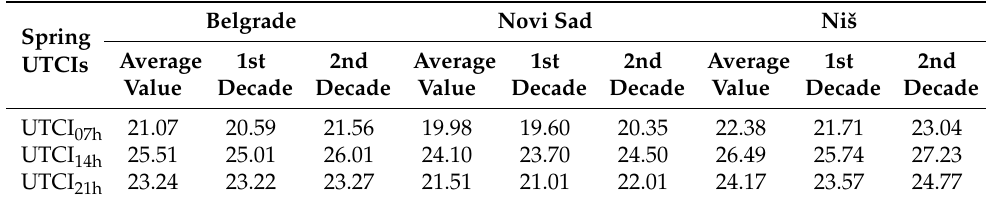
Table 3. Average spring UTCIs values in Belgrade, Novi Sad, and Niš for the period 1999–2018, and average decade-long UTCIs values for the 1st decade (1999–2008) and 2nd decade (2009–2018).